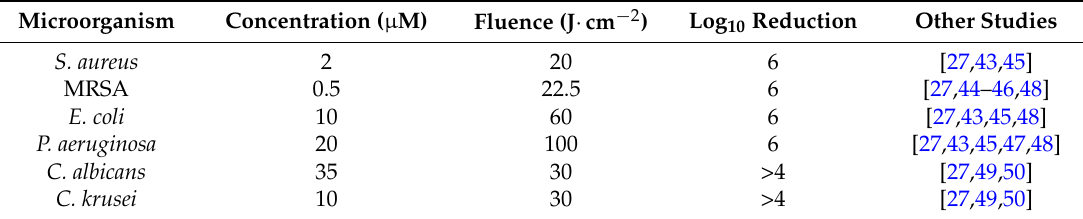
Table 2. Optimal conditions for photoinactivation of microbial pathogens with porphycene 2. References to related aPDT studies for